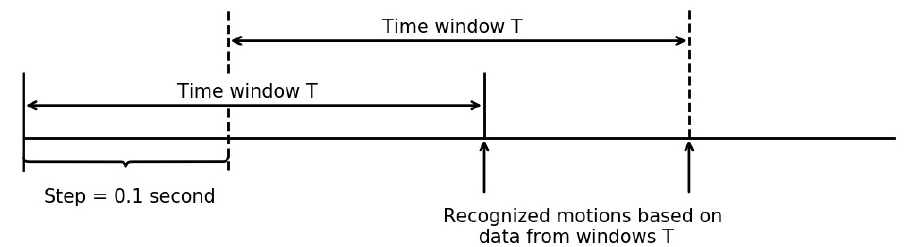
Figure 3. An example of two consecutive time windows for which signal parameters were computed.